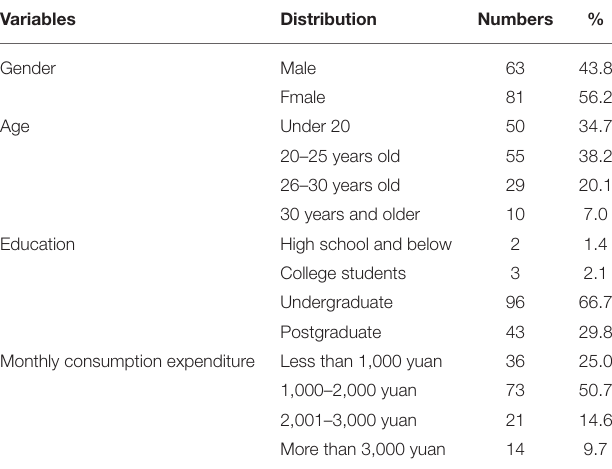
TABLE 1 | Demographic information of participants in Experiment